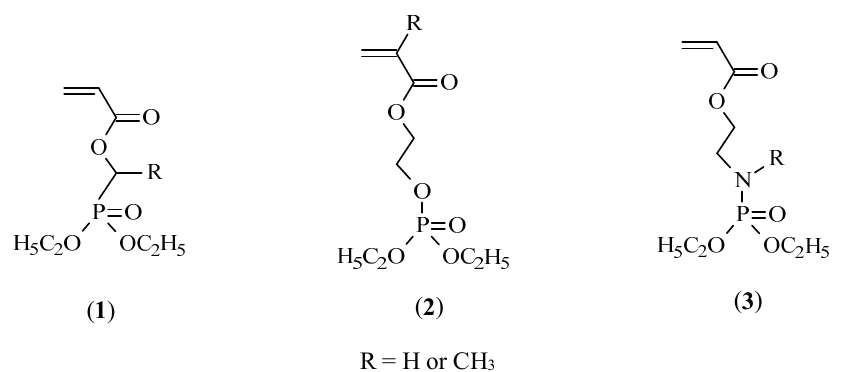
Figure 1. Structures of P- or P-/N-containing comonomers: ( 1 ) diethyl(acryloyloxymethyl)